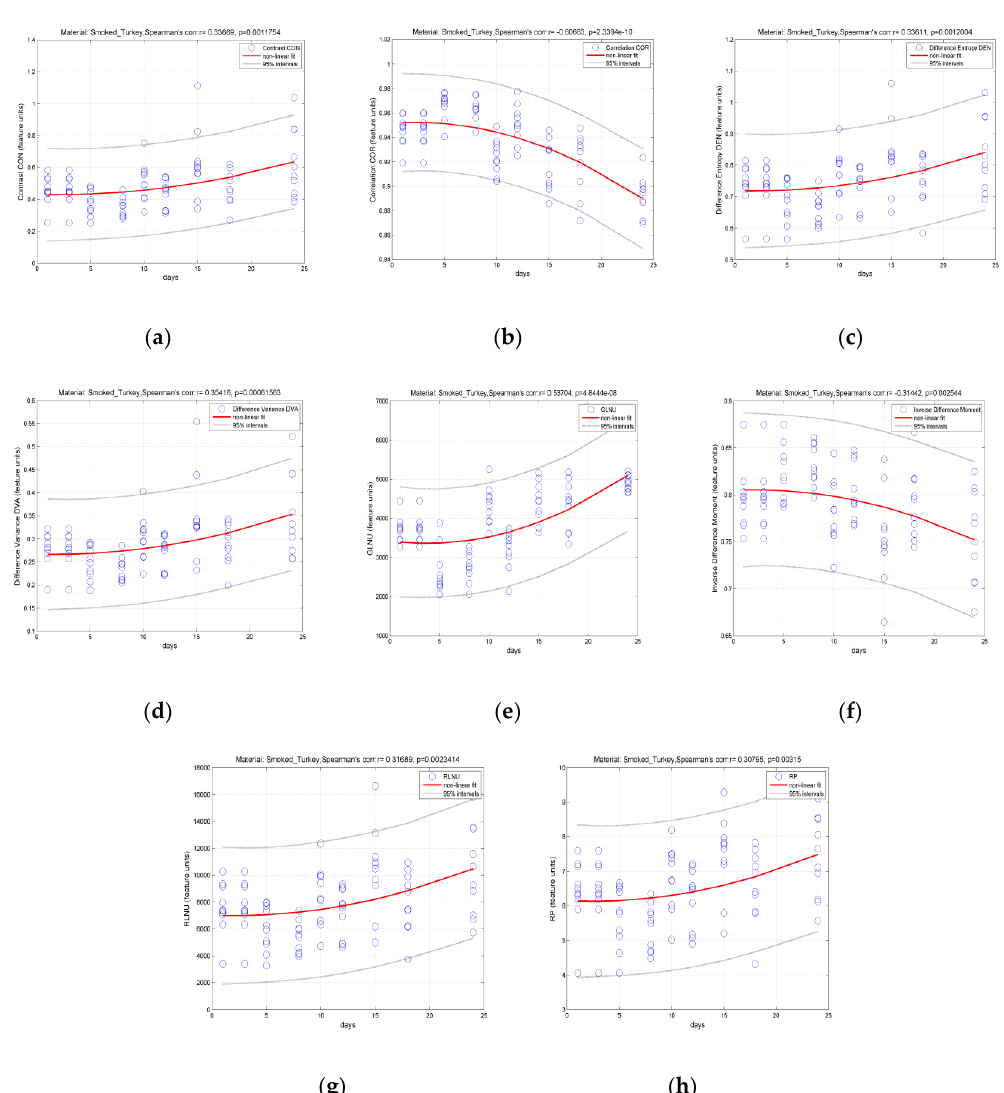
Figure A4. Variation of features ( a ) contrast, ( b ) correlation, ( c ) difference entropy, ( d ) difference